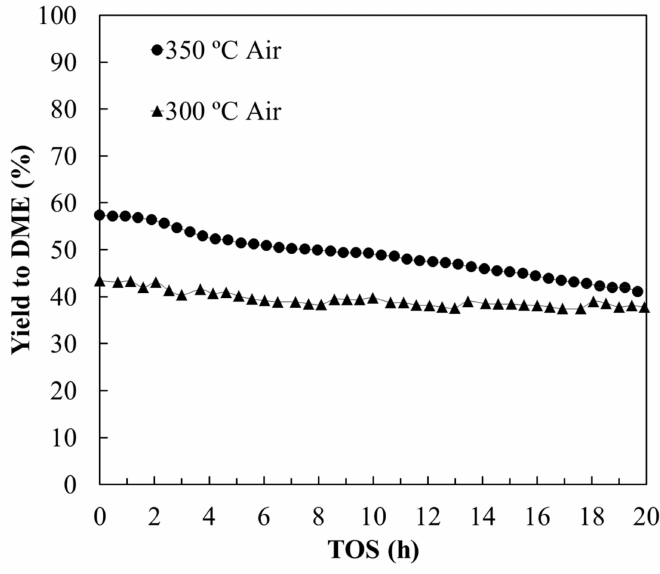
Figure 6. DME yield as a function of the time on stream at di ff erent reaction temperatures for OS2 monolith under air atmosphere. P MeOH = 0.03 atm, W / F MeOH = 0.1 g · s / µ